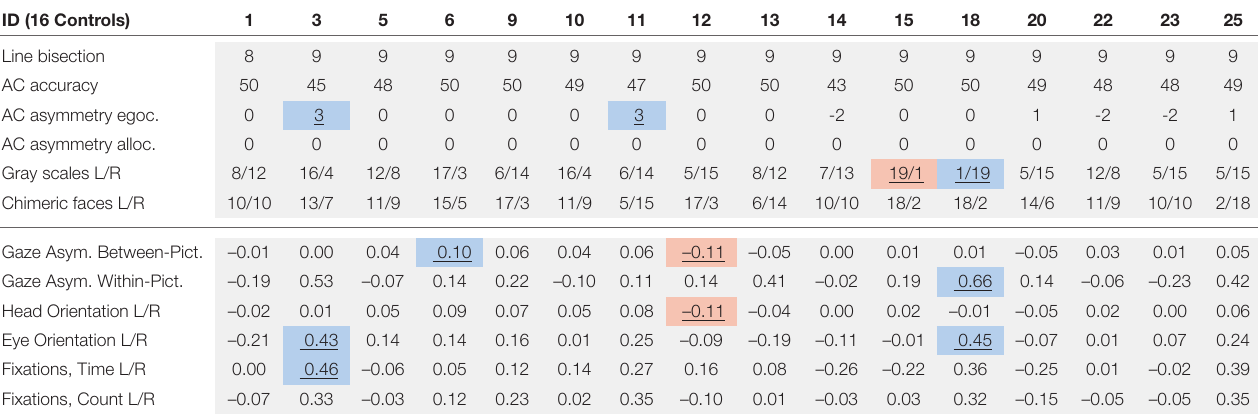
TABLE 6 | Control group demographics and results from conventional and VR